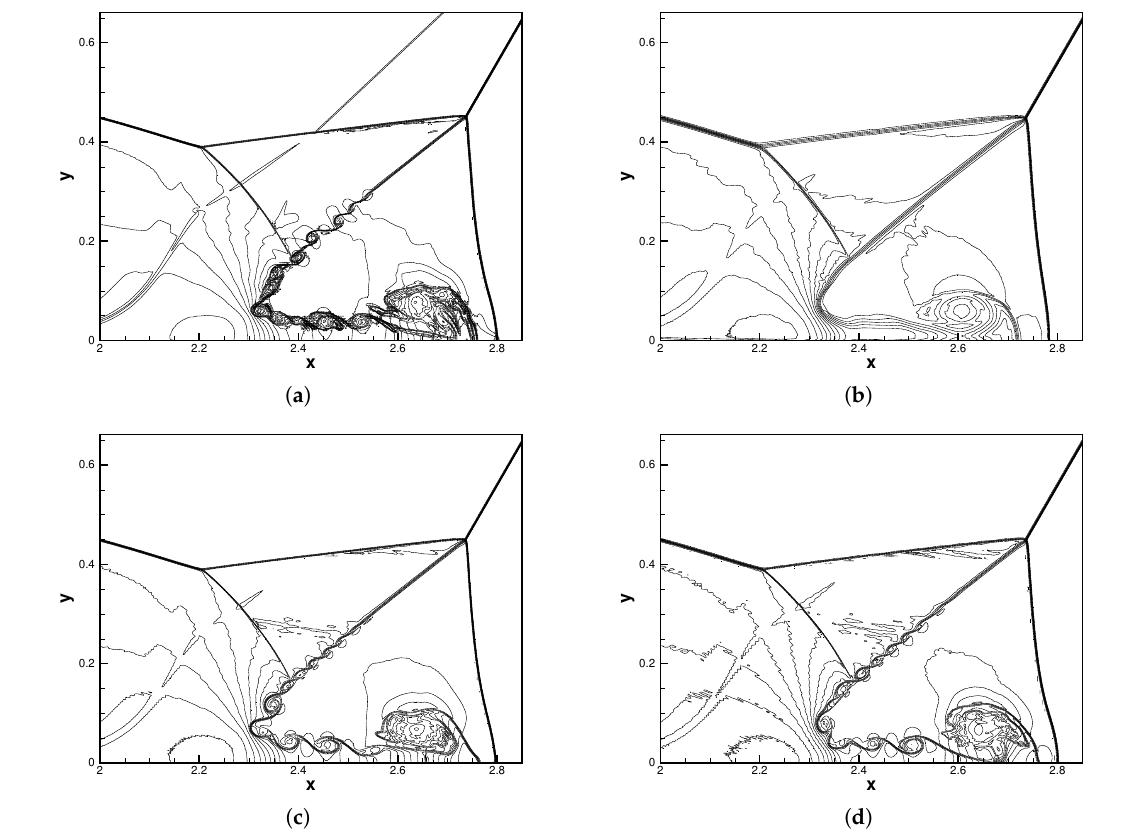
Figure 23. Density solution for the double Mach problem with 816 × 204 P 4 elements at t = 0.2. Thirty-three equally spaced contours from 1.75 to 22.7. ( a ) DB; ( b ) MDH; ( c ) MDA; ( d )